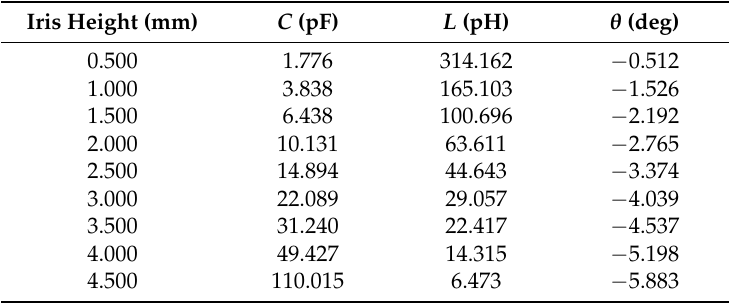
Table 2. Equivalent circuit parameters for the iris configurations.